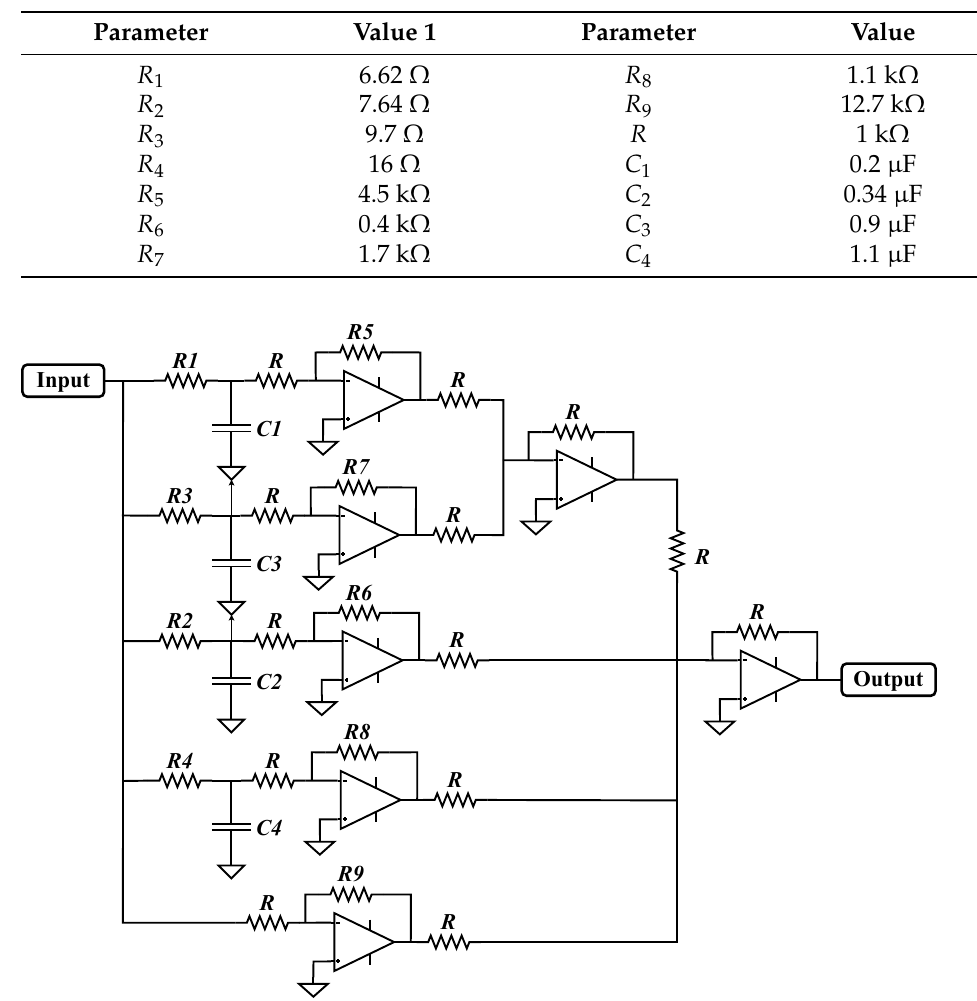
Figure 6. Electrical diagram to generate the partial fraction expansion (19). Prior to validating the effectiveness of the proposed controller, simulation results from PSIM are shown in Figure 7. The regulation of the output voltage v o ( t ) for the reference signal v r = 25 V and its average value are shown. The inductor current in also shown in this figure in order to corroborate the CCM operation. Notice that the fractional-order PID controller approximation (18) successfully regulates the voltage of the boost converter from Figure 1. It took approximately 1 ms for the proposed controller (18) to make the plant reach the reference